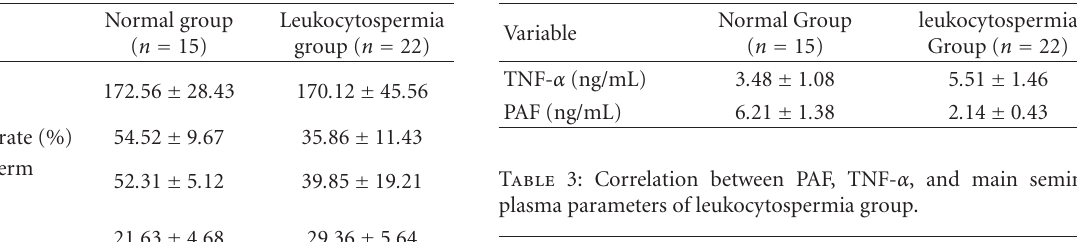
Table 1: Comparison of main seminal plasma parameters between leukocytospermia group and normal group.